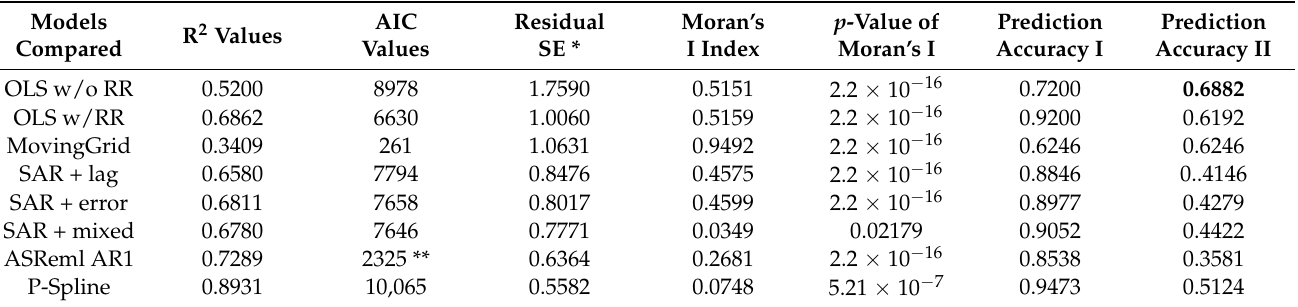
Table 6. Summary of the comparison among different models via R 2 , residual variance, predic- tion accuracy, and Moran’s I index from data set 1. The most desirable values in each column are